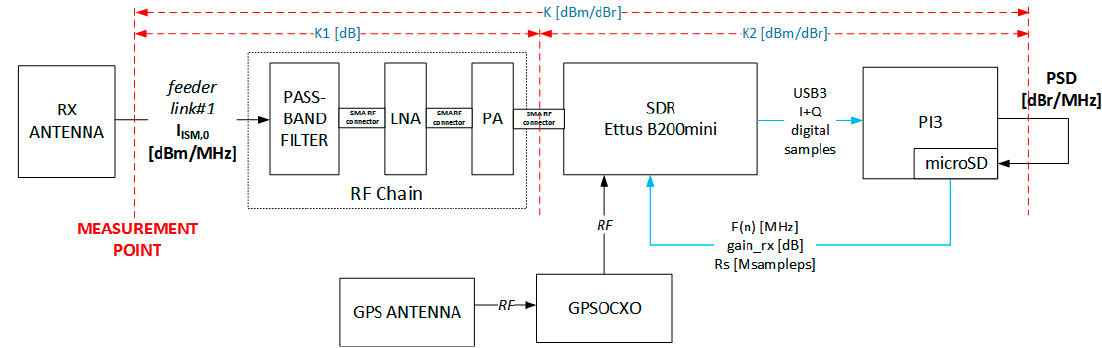
Figure 6. Schematic of the RF payload.